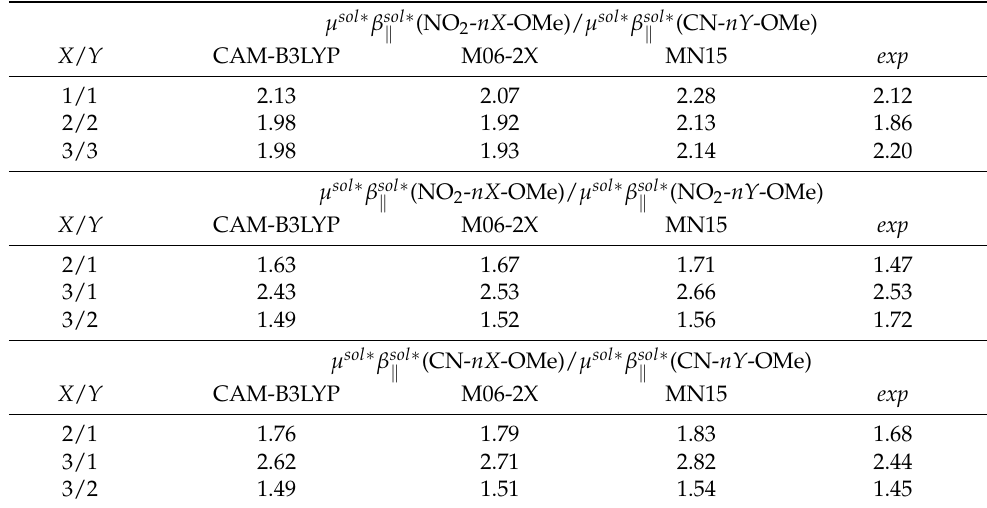
Table 4. Relative ( X / Y ) µ sol ∗ β sol ∗ ( − 2 ω ; ω , ω ) signals of studied systems. X / Y values denote the (cid:107) bridge sizes of systems in the ratio given in the individual mid-table